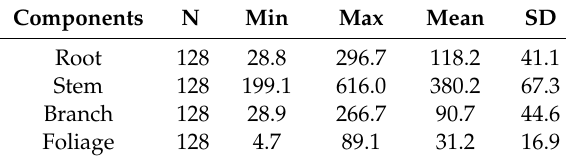
Table 5. Constant (average value) of BCEF s calculated for Populus × xiaohei trees (kg / m 3